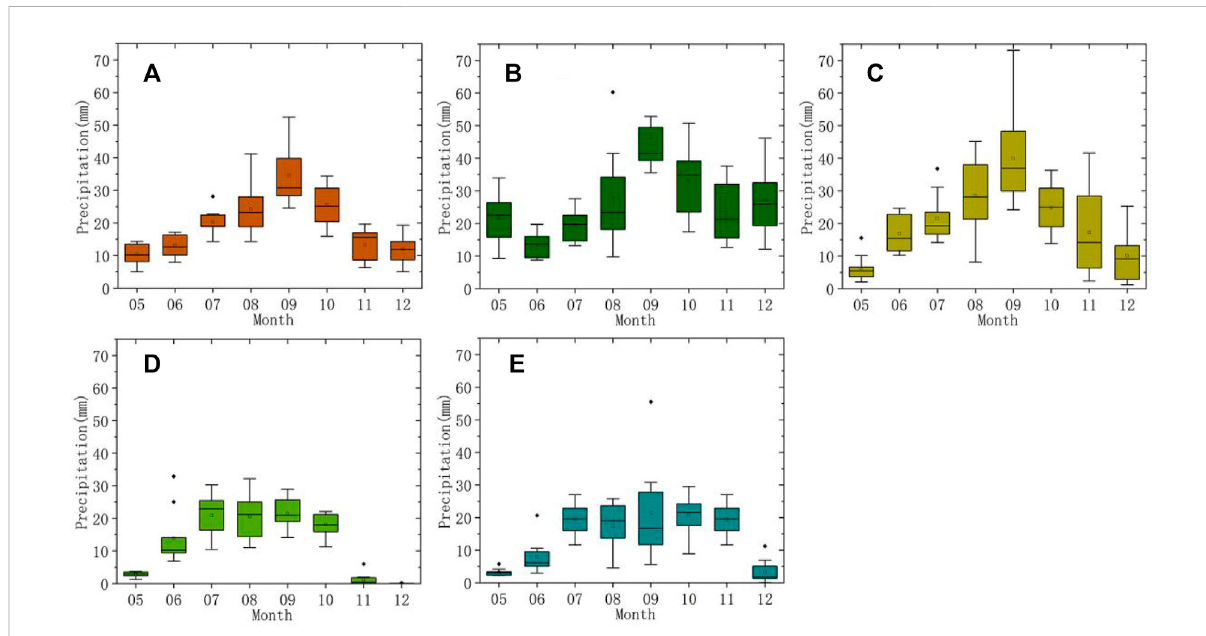
FIGURE 3 The monthly average precipitation in (A) the Northeast Passage, (B) Barents Sea, (C) Kara Sea, (D) Laptev Sea, and (E) East Siberian